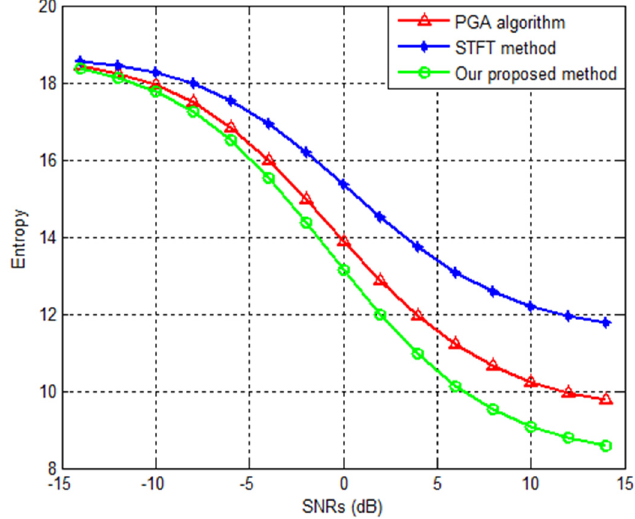
Figure 12. Image Entropy against different SNRs.